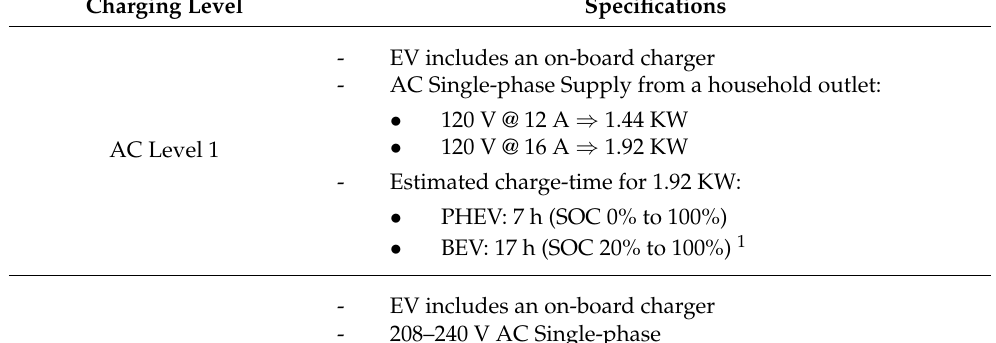
Table 2. Levels charging available in SAE J1772 (2017)